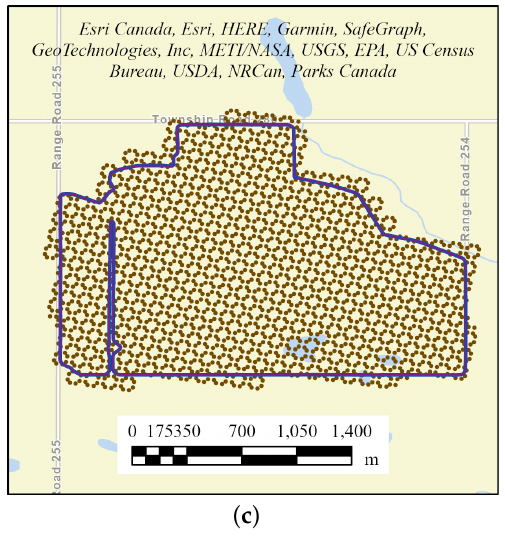
Figure 15. Distance transform sample points and corresponding boundaries imported into ArcGIS Pro for ( a ) the province of Ontario, ( b ) the city of Calgary, and ( c ) a farm field in Alberta.